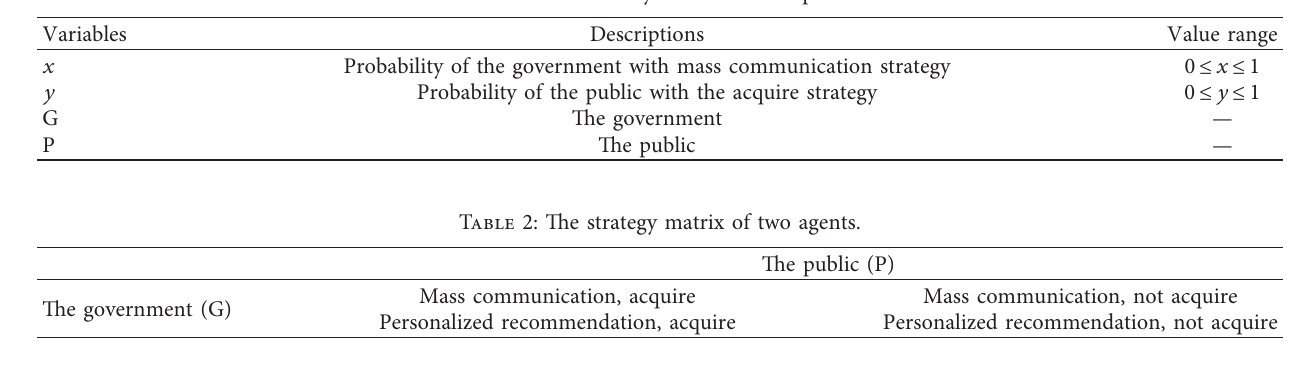
Table 1: Variables symbol and descriptions.